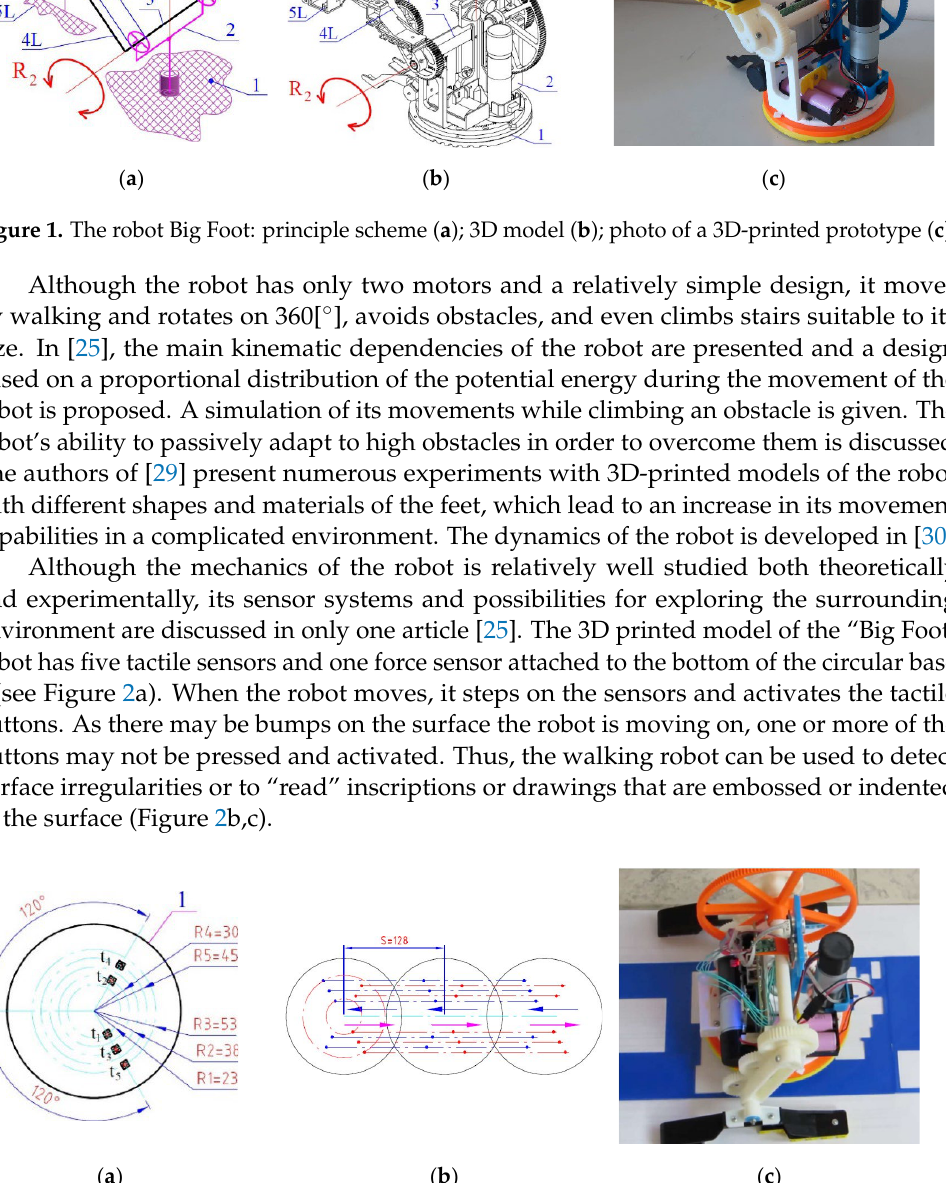
Figure 1. The robot Big Foot: principle scheme ( a ); 3D model ( b ); photo of a 3D - printed prototype ( c ) .